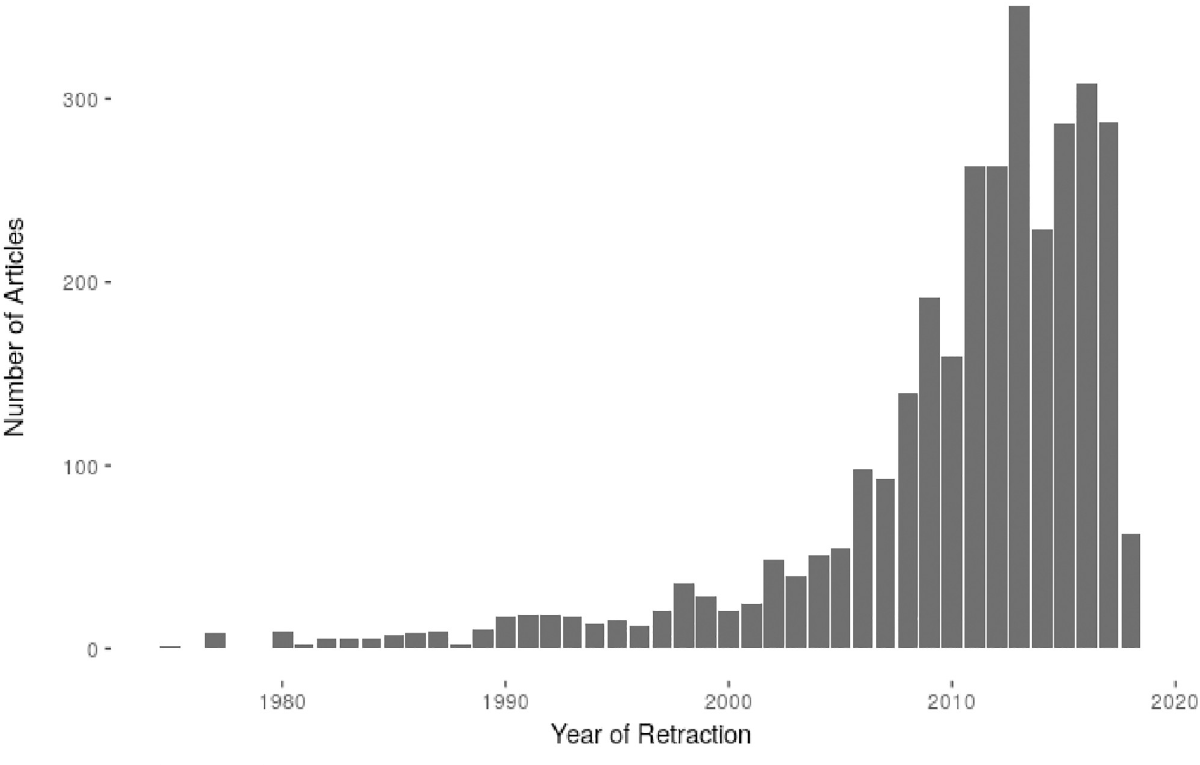
Fig 2. Frequency of retractions by retraction